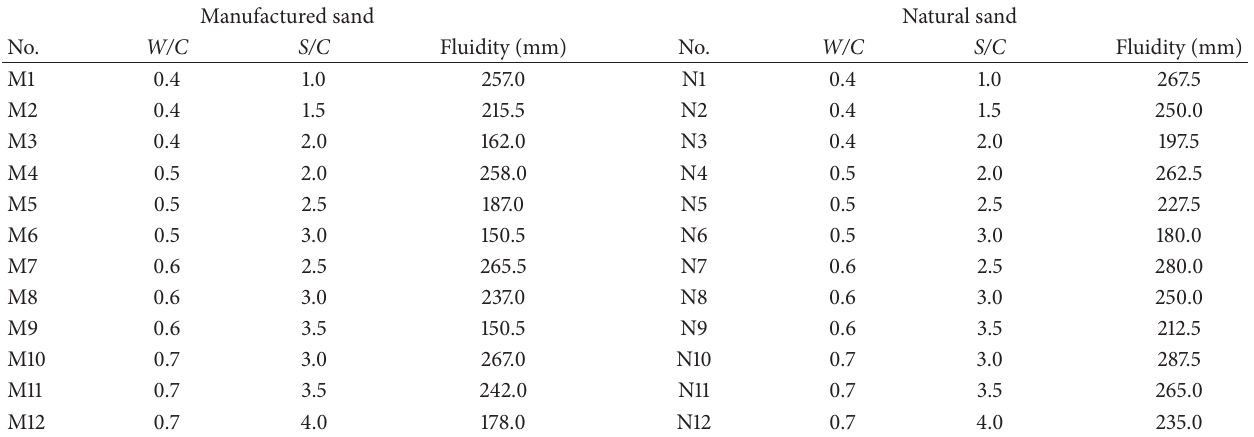
Table 2: Mix proportion and workability of mortar.